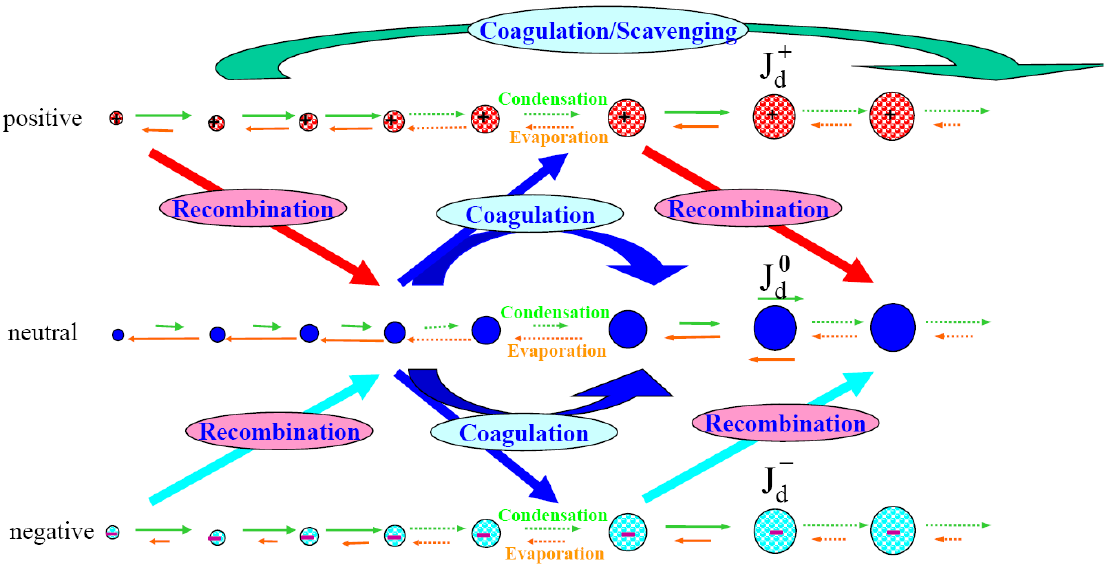
Fig. 1. Schematic illustration of the kinetic processes (condensation, evaporation, coagulation, and recombination) controlling the evolution Figure 1. of positively charged, neutral, and negatively charged clusters/particles that are explicitly simulated in the size-, composition-, and type- resolved ion-mediated nucleation (IMN) model. J + , J 0 , and J − are, respectively, the “apparent” formation rate (or net flux) of positively d d d charged, neutral, and negatively charged particles at a given diameter ( d ). Modified from Yu